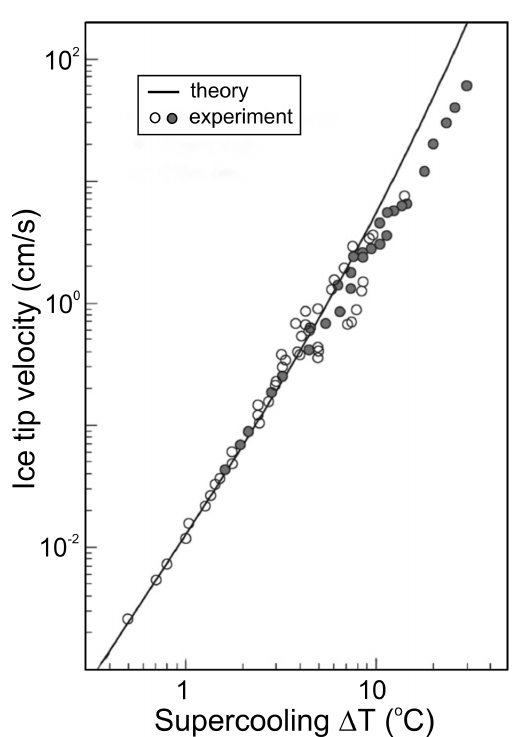
Figure 3. Summary of the measured velocity of freely growing ice as a function of supercooling measured by Lindenmeyer et al. (1959), Hallett (1964), Pruppacher (1967a), Kallungal and Bar- duhn (1977), Furukawa and Shimada (1993), and Feuillebois et al. (1995); Ohsaka and Trinh (1998) (open circles); and Shibkov et al. (2003) (solid circles). The theoretical curve is based on Langer and Müller-Krumbhaar (1978) results. Adapted from Shibkov et al.